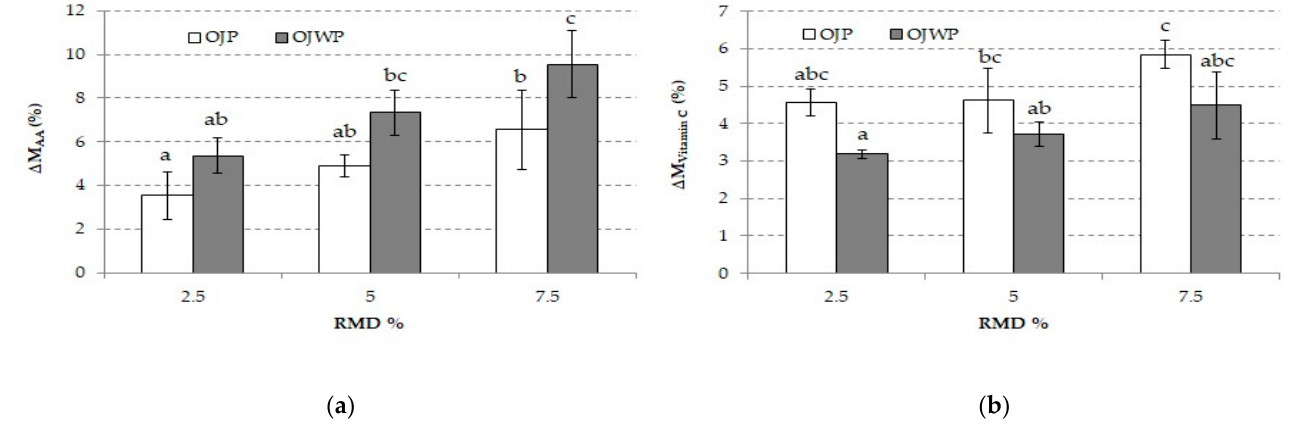
Figure 2. ( a ) Mean values and standard deviation of ascorbic acid variation of pasteurized orange juice (OJP and OJWP) with 2.5, 5, and 7.5 RMD%; ( b ) Mean values and standard deviation of vitamin C variation of pasteurized orange juice (OJP and OJWP) with 2.5, 5, and 7.5 RMD%. Letters indicate homogeneous groups established by the ANOVA ( p < 0.05) for each parameter analyzed. OJP, orange juice with pulp; OJWP, orange juice without pulp.